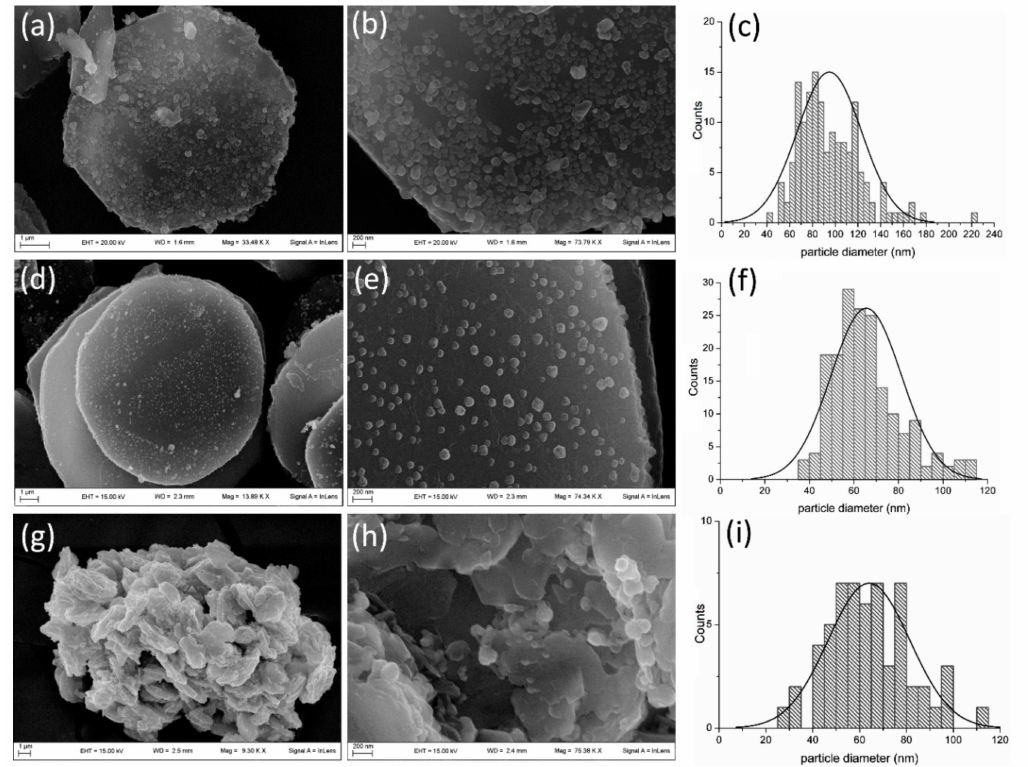
Figure 3. FE-SEM images and size distribution and population of AgCl on layered double hydroxides (LDHs) for: LDH1 ( a – c ); LDH2 ( d – f ); and LDH3 ( g – i ).